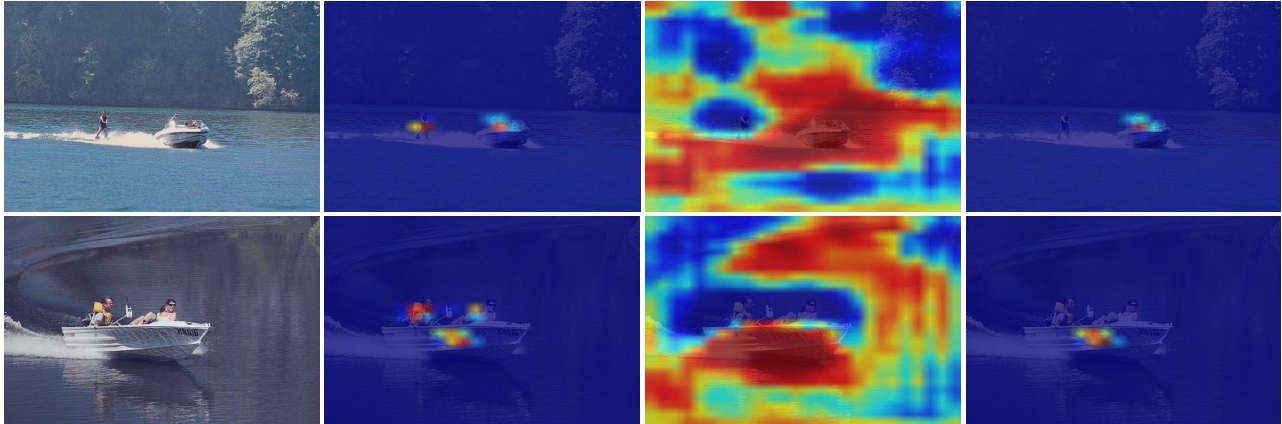
Figure 9. The heatmaps of a ship.